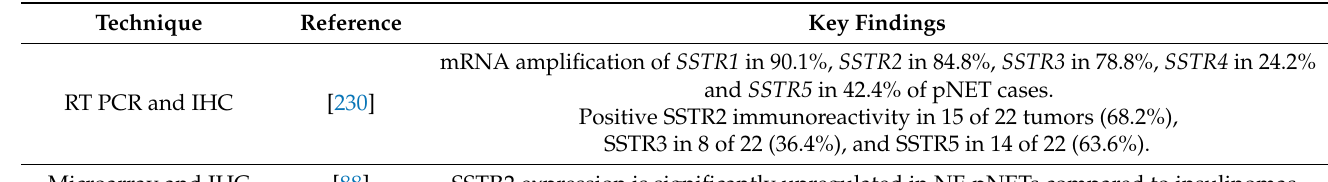
Table 9. Molecular profiling studies on SSTR signaling in